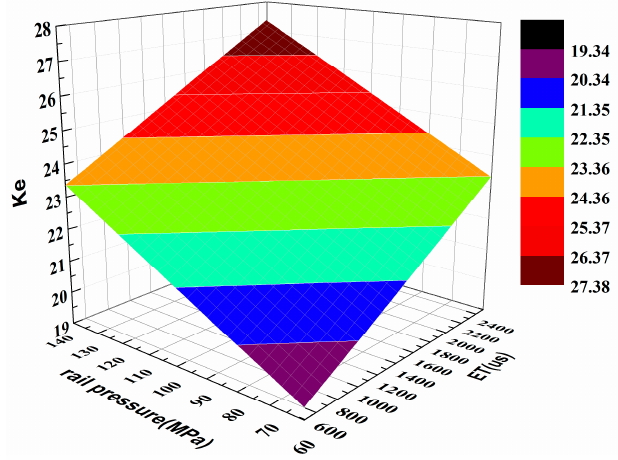
Figure 8. K e distribution at different rail pressures and ET.